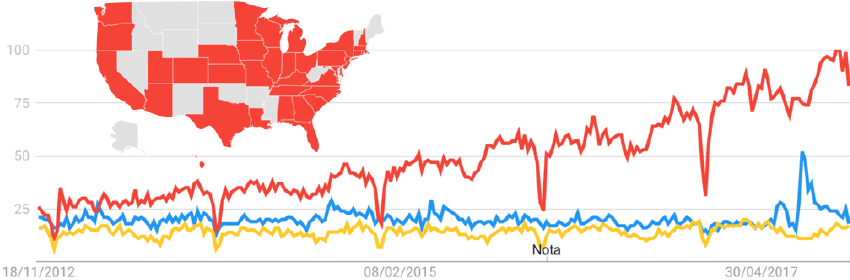
Fig. 6. World Interest along the time. TRIZ (blue) vs. Design Thinking (red) and Open Innovation (yellow) as a search terms in https://trends.google.com for the last five years. 100% translates a peak of